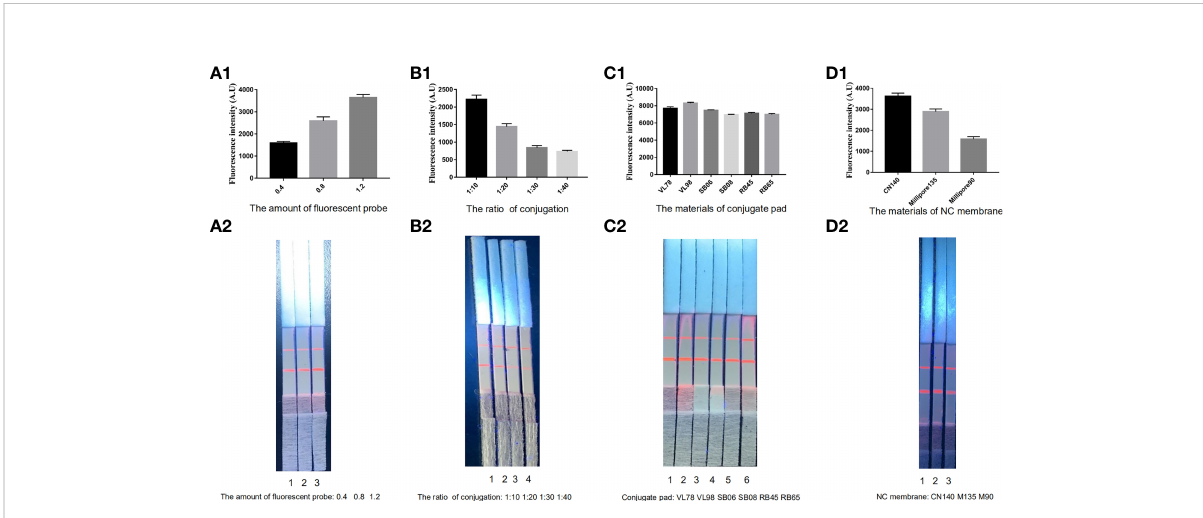
FIGURE 2 Optimization of the ECM-ICS. (A) Fluorescent particles sprayed on conjugate pads 1 – 3: 0.4, 0.8, and 1.2 µg. (B) The rate of ES antigens conjugated with fl uorescent particles 1 – 4: 1:10, 1:20, 1:30, and 1:40. (C) The materials of conjugate pads 1 – 6: VL78, VL98, SB06, SB08, RB45, and RB65. (D) The materials of NC membranes 1 – 3: CN140, Millipore 135, and Millipore 90. ECM-ICS was analyzed by the TRF reader (A1, B1, C1, D1) . Visual results of the ICS under ultraviolet light (A2, B2, C2, D2) .